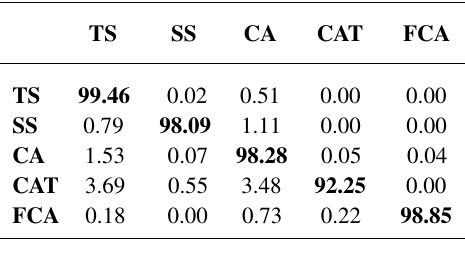
Table 4. Confusion matrix March 2018